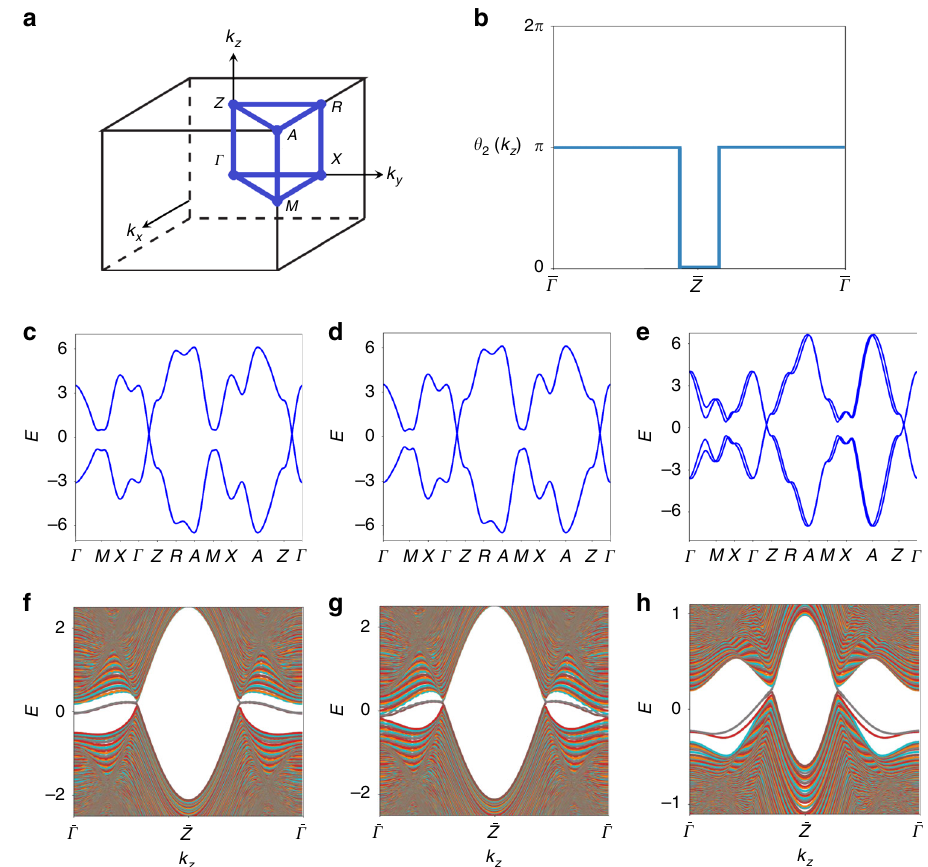
Fig. 3 HOFA states in magnetic, nonmagnetic, and fragile topological Dirac semimetals. a The BZ, c bulk bands, and f hinge bands of a z -directed rod of a T -broken 3D Dirac semimetal with HOFAs in magnetic SG P 4 = m 0 mm (Eq. (5)). The Hamiltonian of each k z slice describes either a trivial insulator or a QI, and the bulk Dirac points occur at the quantum critical points between the two phases. d HOFAs can also be realized in a closely related T -symmetric Dirac semimetal in SG 123 P 4 = mmm 1 0 (Eq. (6)). g Here, the Hamiltonian of the k z = 0 plane is in the 2D TCI phase 10 shown in Fig. 2f, g, and therefore there is no gap in the hinge-projected surface states at (cid:1) Γ . e Upon breaking M z and I symmetries by adding Eqs. (3) – (6), which reduces the symmetry to SG 99 ( P 4 mm 1 0 ), h the face TCI cones gap as they did previously in Fig. 2i – k, resulting in a noncentrosymmetric Dirac semimetal without surface states 21 whose only topological boundary modes are HOFA states. h Two sets of weakly split HOFAs meet in Kramers pairs at (cid:1) Γ ; if the system fi lling is fi xed to 1 ∕ 2 (i.e., to the fi lling of the Dirac points), then one set of HOFA states in h is half- fi lled and carries a topological quadrupole moment, and the other set is fully fi lled, and is topologically trivial. At (cid:1) Γ , this implies that the Kramers pairs of hinge states are three-quarters fi lled, and that they exhibit the same quadrupole moment (modulo e ) as a QI (Supplementary Note 9). The Hamiltonian of the k z = 0 plane in e , h exhibits the same fragile topology as the 2D model in Fig. 2i – k (Supplementary Note 4), implying that the hinge states at (cid:1) Γ are equivalent to the fractionally charged corner modes of a 2D fragile TI. The model (Eqs. (6) and (3)) shown in e , h therefore represents a previously uncharacterized variant of topological semimetal that carries observable signatures of fragile topology. b The 3D semimetallic phases of Eqs. (5) and (6), whether or not Eq. (3) is additionally present, exhibit the same quadrupole-quantized nested Berry phase 23 θ 2 ( k z